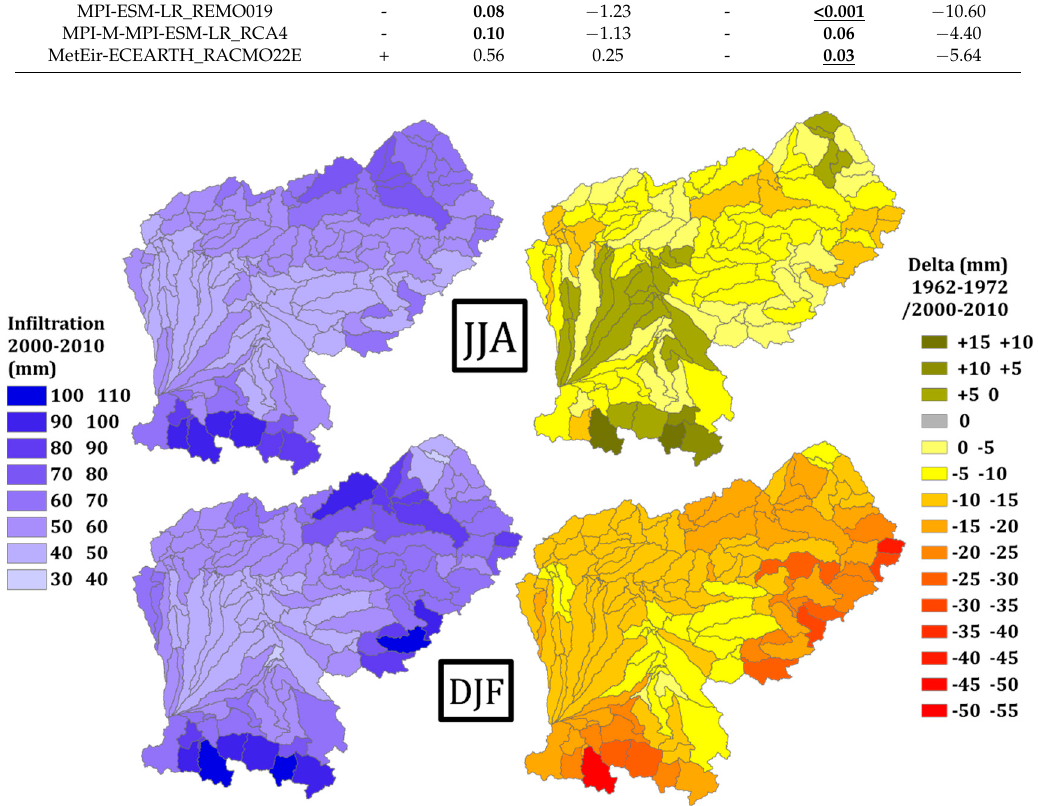
Figure 9. Infiltration during the 2000–2010 decade and variations with the 1962–1972 decade.